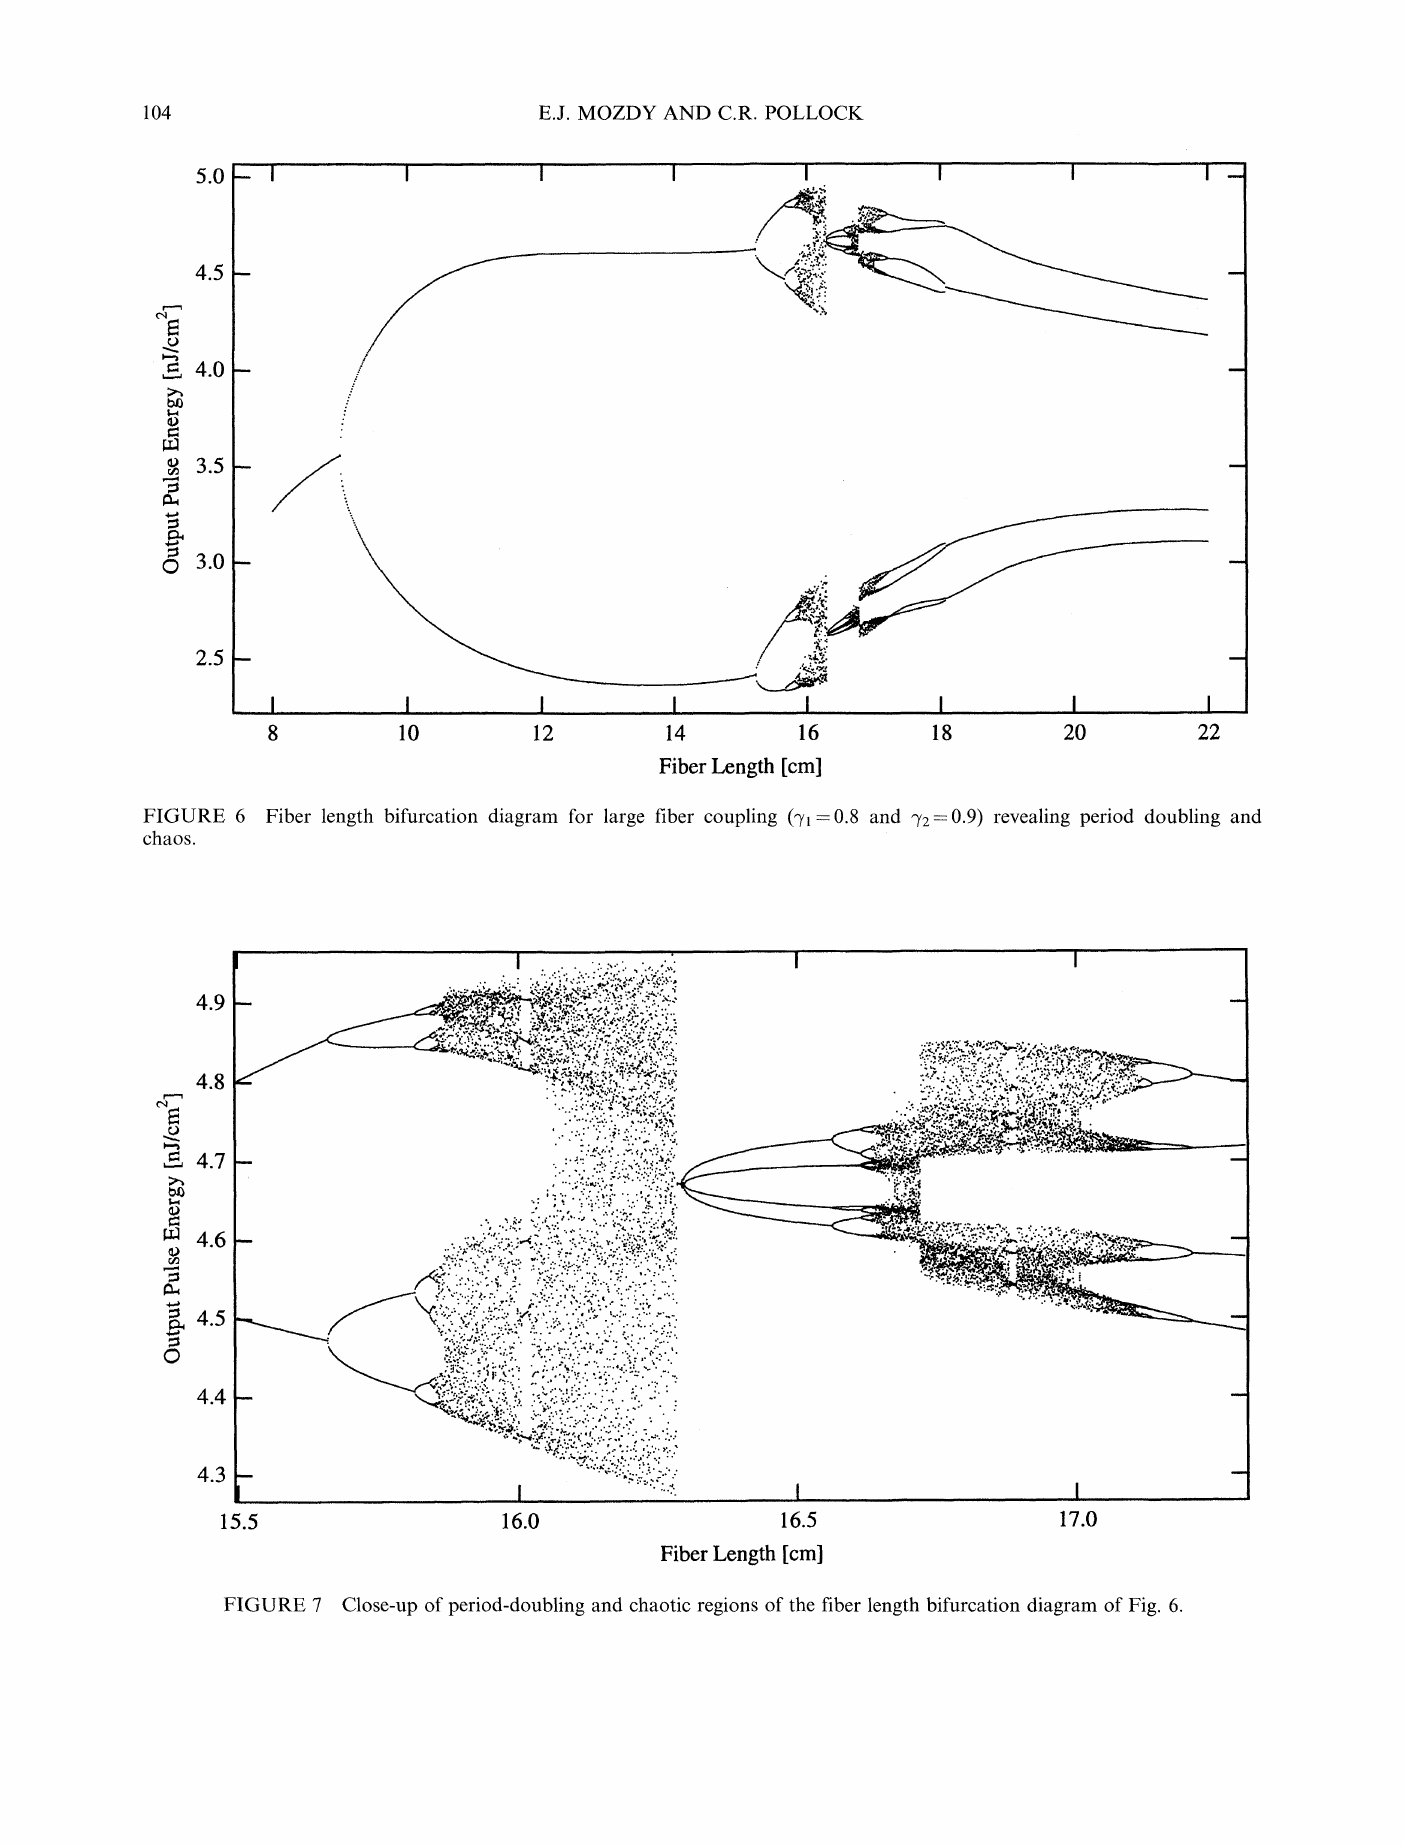
FIGURE 7 Close-up of period-doubling and chaotic regions of the fiber length bifurcation diagram of Fig.